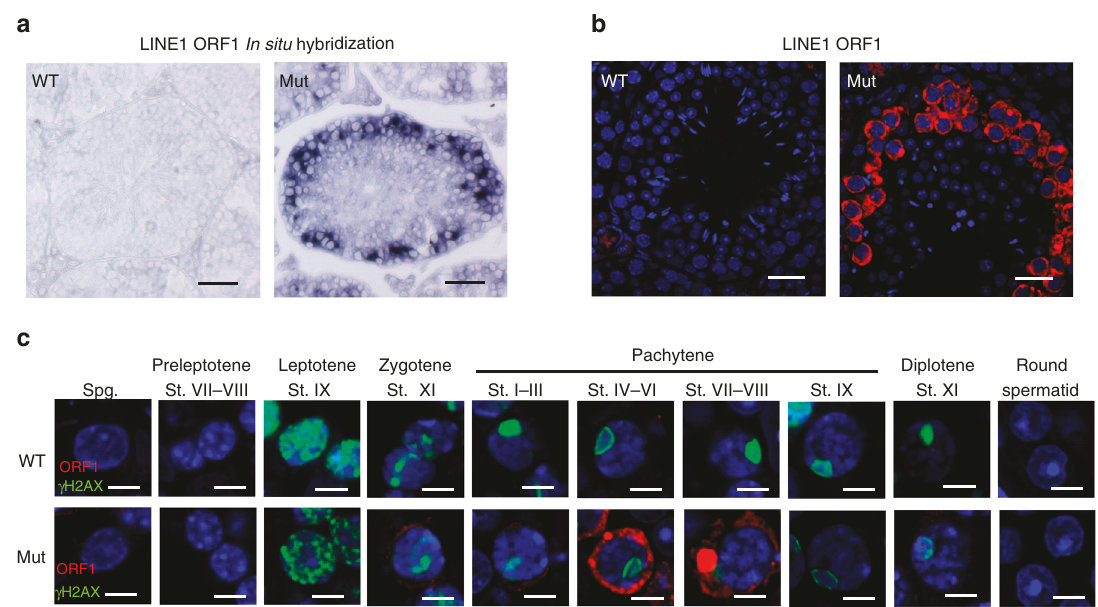
Fig. 2 Retrotransposon LINE1 derepression in Pnldc1 mutant spermatocytes. a In situ hybridization of LINE1 Orf1 mRNA in adult WT and Pnldc1 Mut (Mut-1) testes. LINE1 Orf1 mRNA was upregulated in spermatocytes in Pnldc1 Mut testes but was undetectable in WT testes. Scale bar , 50 μ m. b Immunostaining was performed using LINE1 ORF1 antibody on adult testis sections from WT and Pnldc1 Mut (Mut-1) mice. LINE1 ORF1 was upregulated in spermatocytes in Pnldc1 Mut testes but was undetectable in WT testes. Scale bar , 20 μ m. c Immunostaining was performed using LINE1 ORF1 antibody and γ H2AX antibody on adult testis sections from WT and Pnldc1 Mut (Mut-1) mice. Different cell types were distinguished according to γ H2AX staining and DAPI staining.